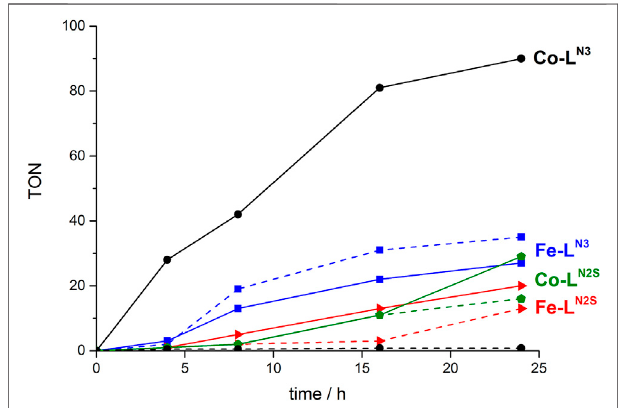
FIGURE 2 | Comparison of catalytic activity of the Fe and Co based catalysts (5 × 10 − 5 M), in DMF applying a λ > 400 nm longpass fi lter, with 5% TEA as SR, Ir(dFppy) 3 and a 200 W Hg-lamp. Dotted line: H 2 formation and solid line: CO formation.